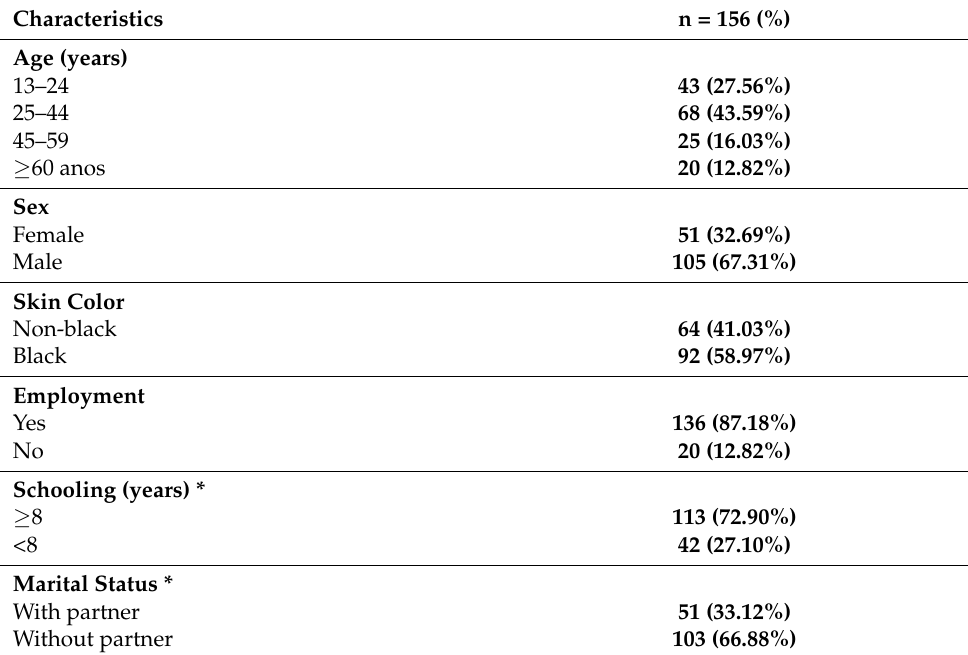
Table 1. Sociodemographic characteristics of suicide